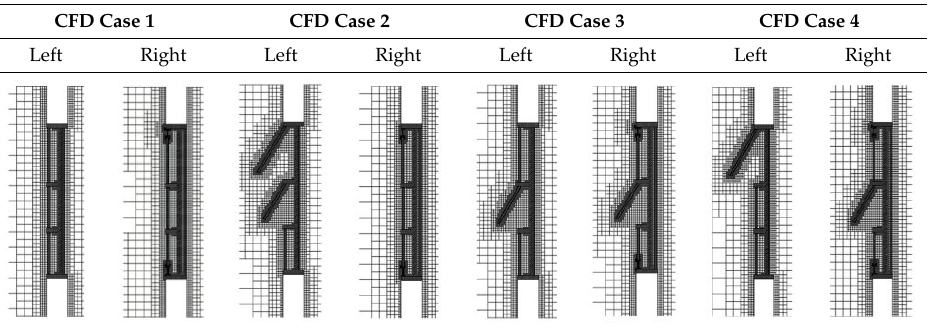
Table 8. Computational grid around the cavity.